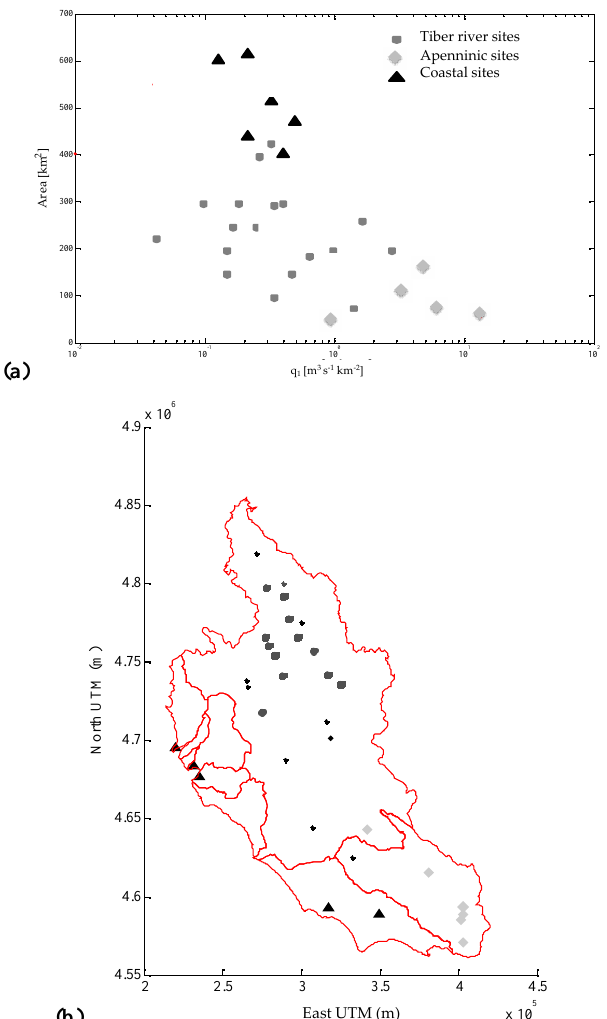
Fig. 4. The scatter plot of basin area against specific quantile of dis- charge q 1 used as qualitative analysis for preliminary identification of structures in the dataset (a) (semi-logarithmic representation). It is possible to recognize three different regions. In the figure below (b) , points of the scatter plot are also identified geographically. The geographical representation points represent the flow level stations.